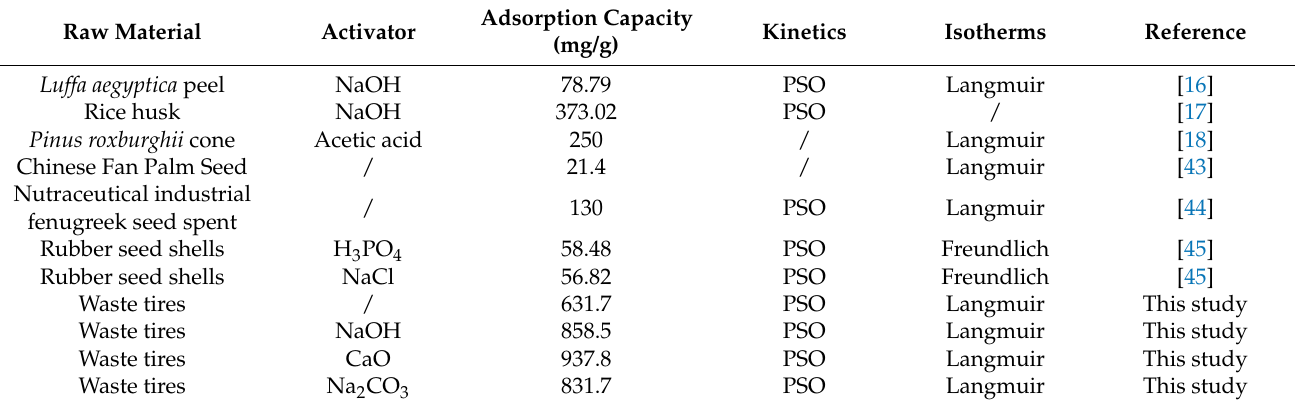
Table 6. Comparison of MG adsorption capacity on different biomass-based